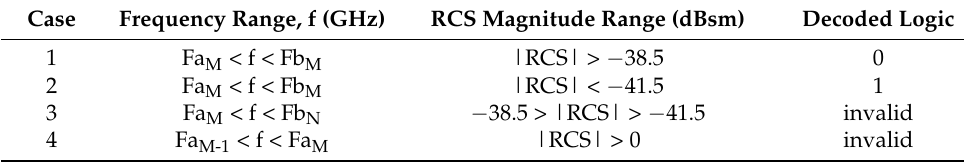
Figure 3. The RCS response allocation. Table 1. Summary of bit decoding process.